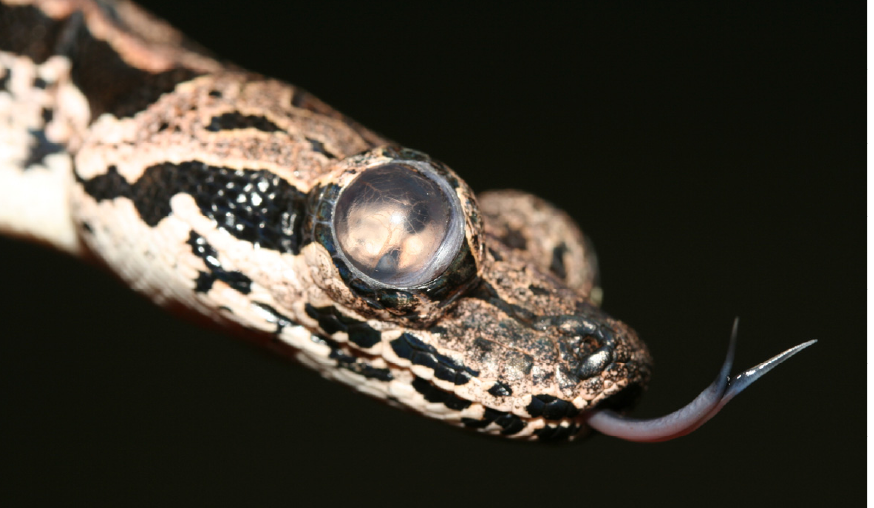
Figure 20. Pseupdobuphthalmos in a neonate Dumeril’s boa ( Acrantophis dumerili ) that is presumably related to developmental abnormalities in the lacrimal drainage system.